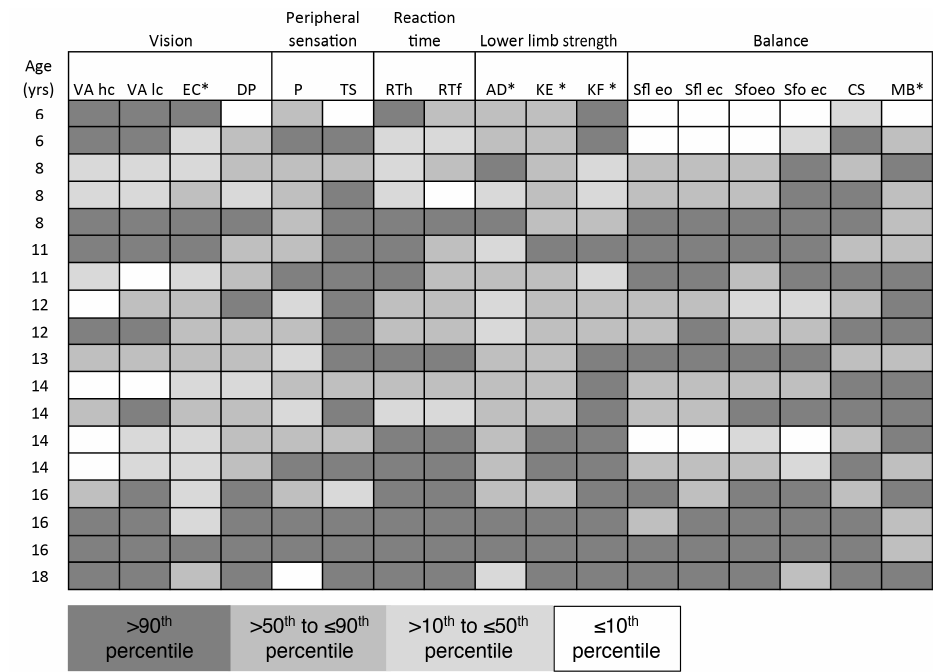
Figure 5. ASD subjects’ profile. Each ASD subject’s PPA performance box is colored with the correspondence of range percentile. Light gray to dark gray corresponds with better to worse performance. Abbreviations: yrs, years; VAhc, visual acuity high-contrast; VAlc, visual acuity low-contrast; EC, edge contrast sensitivity; DP, deep perception; P, proprioception; TS, tactile sensitivity; RTh, hand reaction time; RTf, foot reaction time; AD, ankle dorsiflexors force; KE, knee extensors force; KF, knee flexors force; Sfl eo, sway on floor eyes open; Sfl ec, sway on floor eyes closed; Sfo eo, sway on foam eyes open; Sfo ec, sway on foam eyes closed; CS, coordinated stability test; MB, maximum balance range test. * indicates the percentile scale was inverted so that all items scoring over the 90th percentile indicated poorer performance.